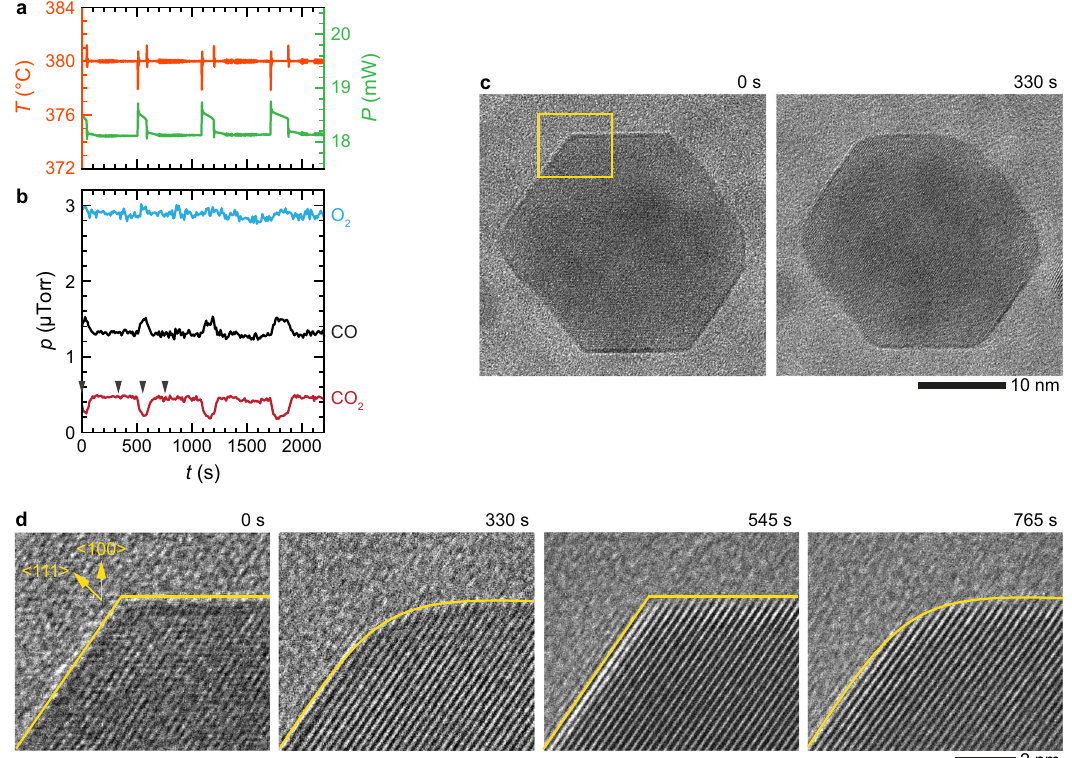
Fig. 2 | Restructuring of a Pd nano-octahedron during an oscillatory CO oxi- image series shown in c , d . c Insitu TEM image seriesof a nano-octahedron in low- dation reaction. a Plots of the measured temperature (orange curve), heater andhigh-activitystatesduringtheoscillation. d High-resolutionimageseriesofthe NP ’ scorner,asindicated bytheyellowboxin c .During thereaction, thecornersof power(greencurve),and b thecorrespondingamountsoftheCO(blackcurve),O 2 the nano-octahedron periodically restructure between high-activity round (330 (bluecurve),andCO 2 (redcurve)gasesduringanoscillatoryCOoxidationreaction ≈ 0 : 5. The arrows in b correspond to the timepoints of the and 765s) and low-activity fl at (0 and 545s) facets (Supplementary Movie at 380°C and p CO = p O 2